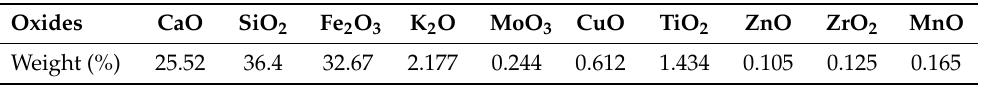
Figure 3. ( a , b ) SEM micrographs; ( c ) XRD graph. Reproduced with permission from Ref. [5]. Copyright (2021), Elsevier Ltd. Table 6. Chemical composition of NGPs. Table 7. Mineral oxide composition of